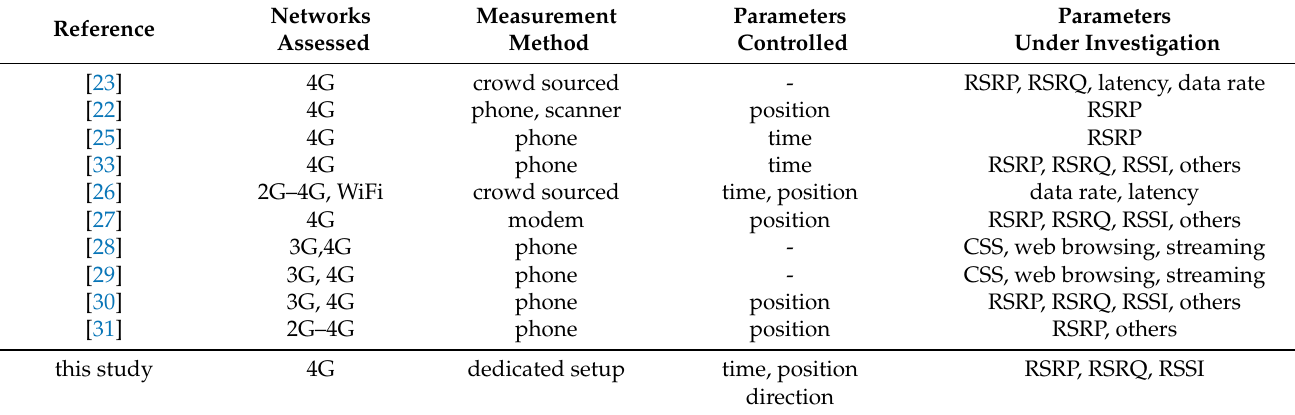
Table 2. Related work and analysis carried out in this